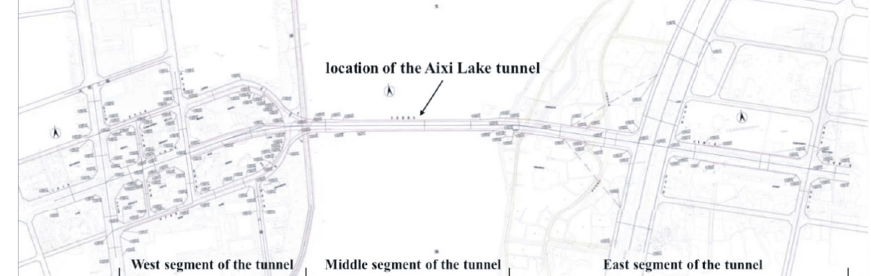
Figure 3: The location map of the Aixi Lake tunnel.